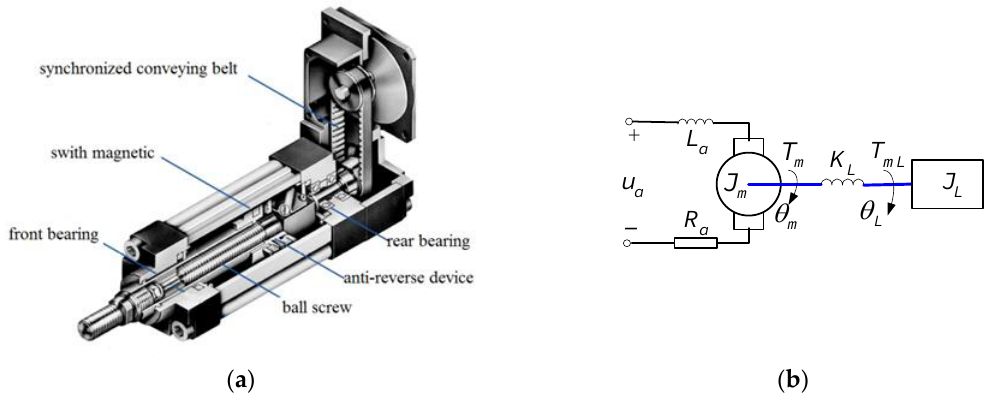
Figure 3. Schematic diagram of the Stewart platform. ( a ) Mechanical schematic of the electric cylinder; and ( b ) equivalent diagram of the electric cylinder.